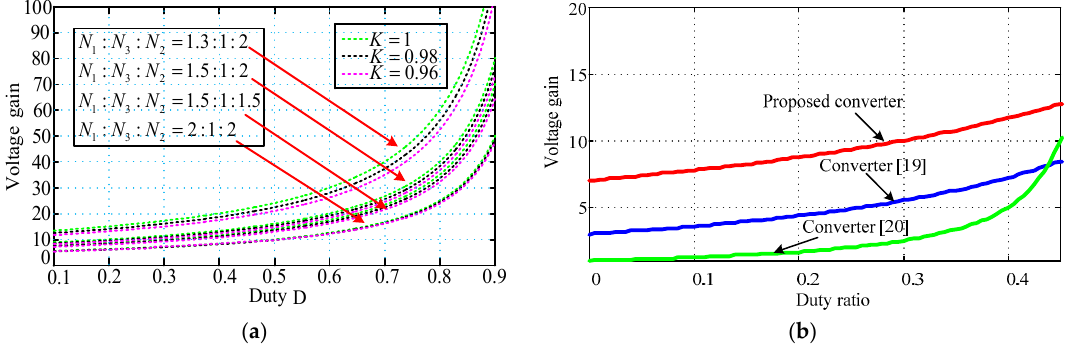
Figure 4. Voltage gain comparisons: ( a ) voltage gain under different coupling coefficients K ; and ( b ) among the proposed converter, the converters in [19,20] at CCM operation under N 3 : N 2 : N 1 = 2:1:4.